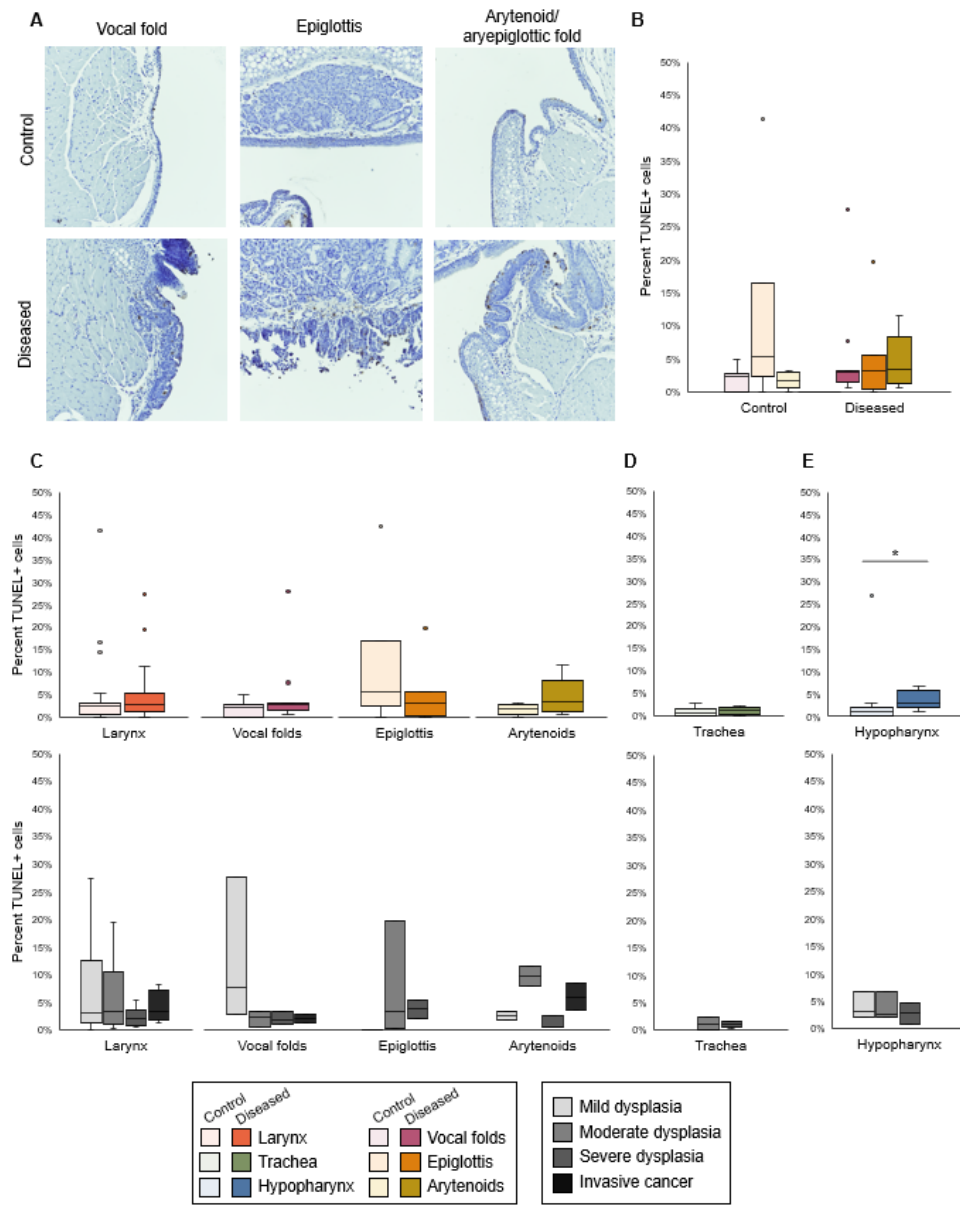
Figure 3. Apoptosis index did not differ in diseased larynx or trachea but increased in diseased hypopharynx. ( A ) TUNEL stain in control and diseased vocal folds, epiglottis, and arytenoids, 30× magnification. ( B ) Difference among laryngeal tissues in % TUNEL+ cells, n = 7–11 mice per tissue type in each condition. Kruskal–Wallis tests: control p = 0.0690, diseased p = 0.8296. ( C ) Control